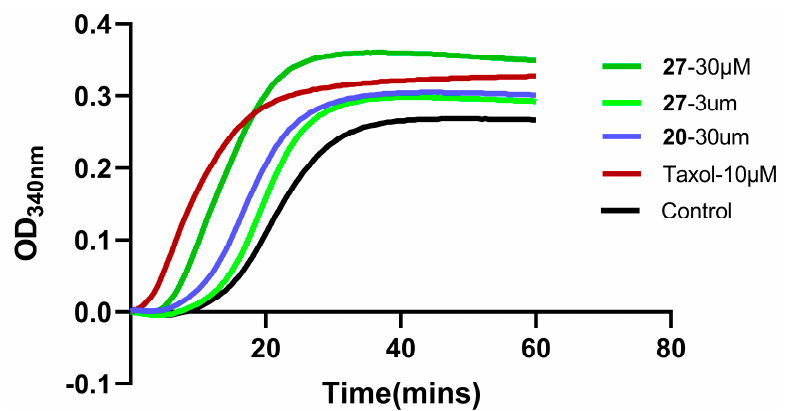
Figure 7. The effect of compound 20 and compound 27 on in vitro tubulin polymerization was tested. Polymerization of purified tubulin was performed in a cell-free assay. Tubulin protein was incubated at 37 °C in a reaction buffer exposed to vehicle control or test compounds at the indicated concentrations. Absorbance at 340 nm was monitored at 37 °C every 30 s for 1 h.